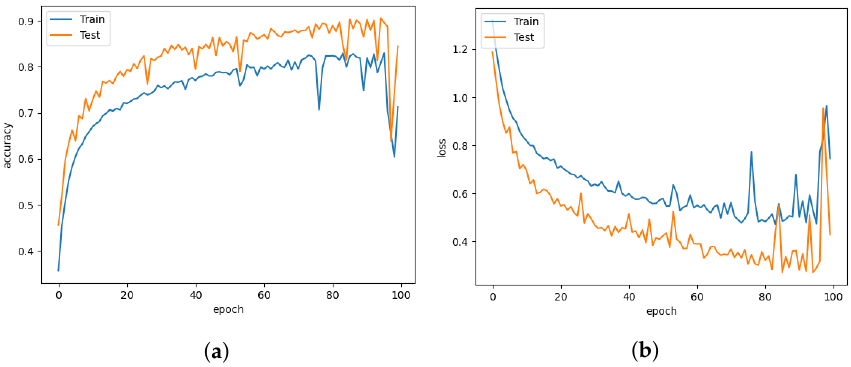
Figure 9. AlexNet for learning rate = 0.001. ( a ) Model accuracy. ( b ) Model